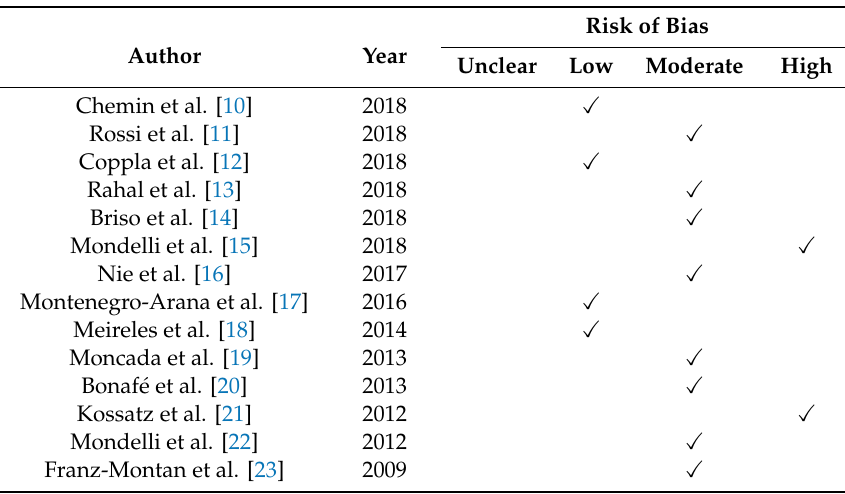
Table 3. Individual risk of